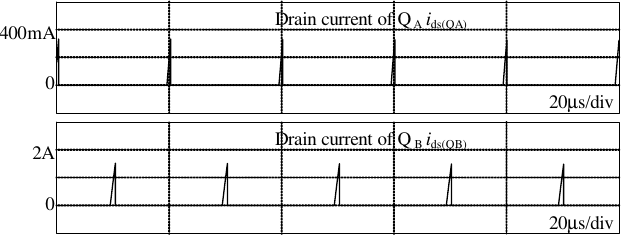
Figure 15. Simulation results of the proposed cooperative control method when the reference LED current I ∗ is 15 mA. LED